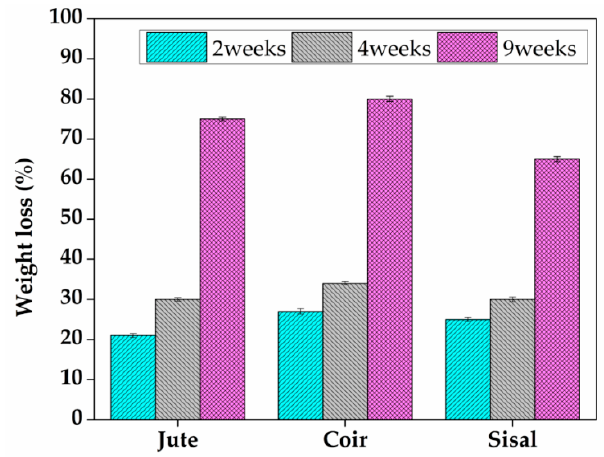
Figure 11. Weight loss after soil burial at 6% of eggshell powder.